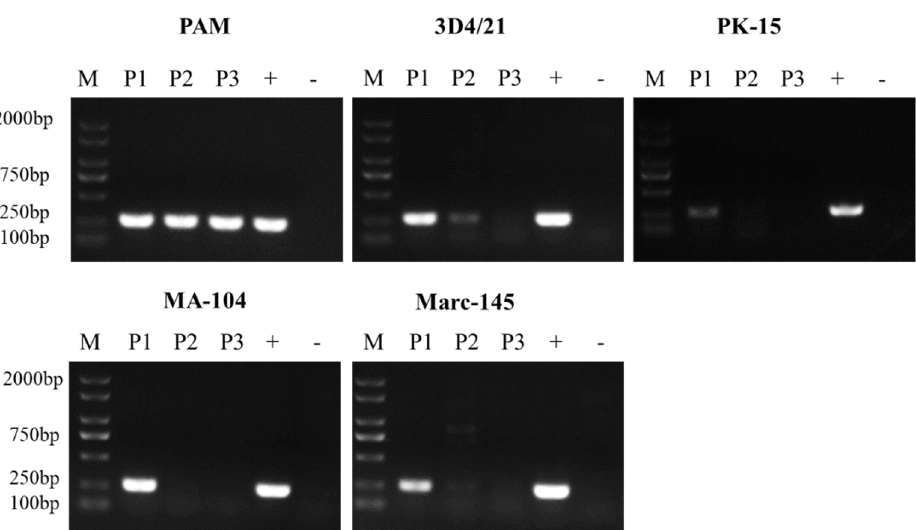
Figure 1. ASFV genomic DNA detection in PAMs, 3D4/21, PK-15, MA-104 and Marc-145 cells. The cells were infected with ASFV at 5 MOI. Virus culture supernatants (P1) were collected at 48 hpi and blind passaged twice (P2 and P3). The P1–3 viruses were detected with PCR with primers for the viral B646L gene. +: PCR positive control. − : PCR negative control.